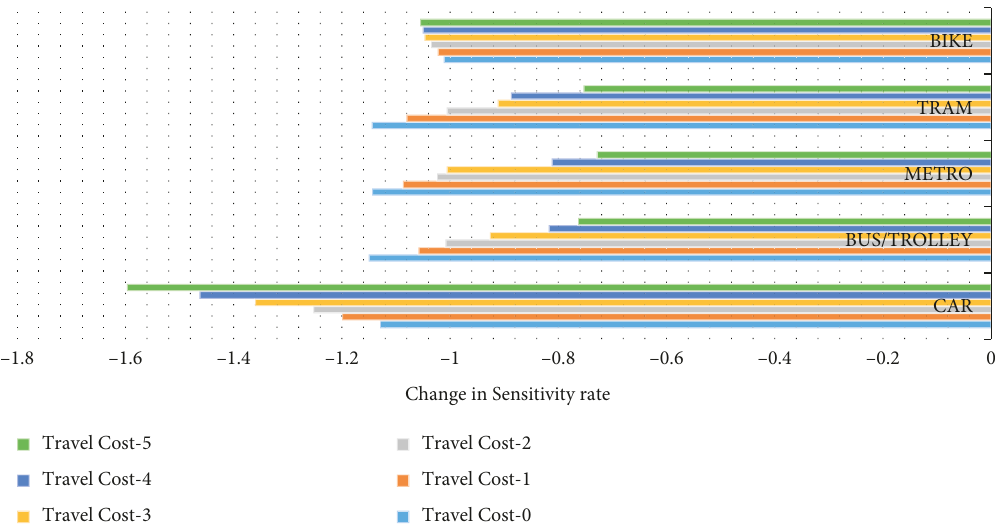
Figure 1: The values of the coefficients based on the changes in the travel cost.